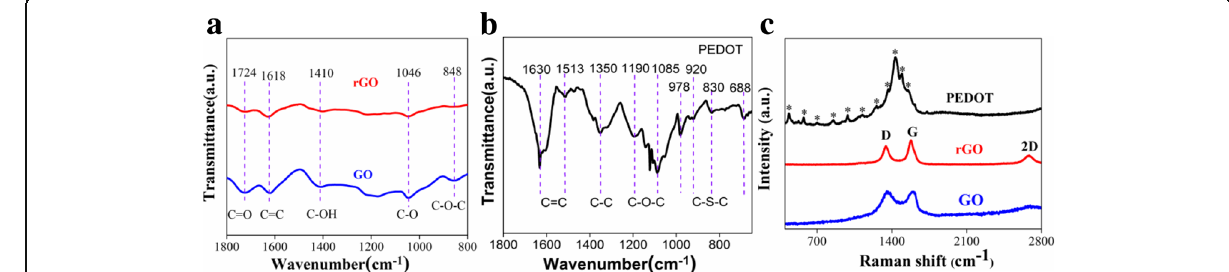
Fig. 3 FTIR spectra of a GO, rGO, and b PEDOT. c Raman spectra of GO, rGO, and